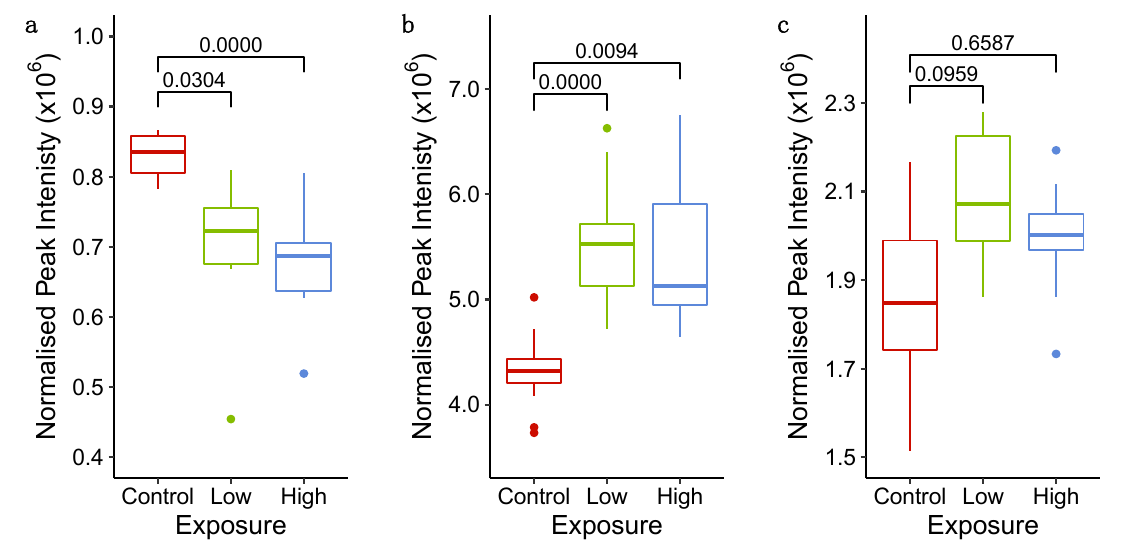
Figure 6. Peak intensities of ( a ) hypoxanthine ([2M − H] − ), ( b ) inosine ([M + H] + ) and ( c ) L-glutamine ([M – H − H 2 O] − ) measured using HILIC UHPLC-MS in the spent culture medium of control (exposed to 0.1% DMSO), low (1.1 µ M sunitinib) and high (3.5 µ M sunitinib) cardiac microtissues at 6 h after exposure. The q -values (one-way ANOVA with Tukey’s honestly significant difference post hoc test and false discovery rate corrected) are displayed.